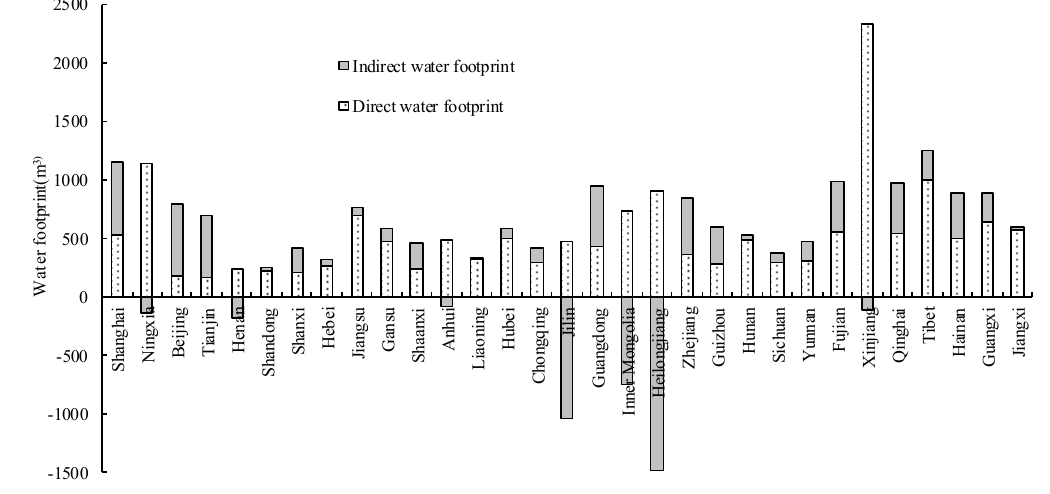
Figure 7. Spatial pattern of the water footprint per capita.